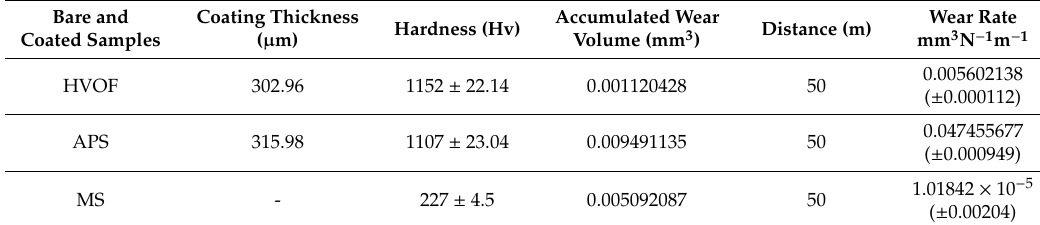
Table 5. Tribometric and micro-Vickers results of substrate and iron-based amorphous coating. Bare and Coated